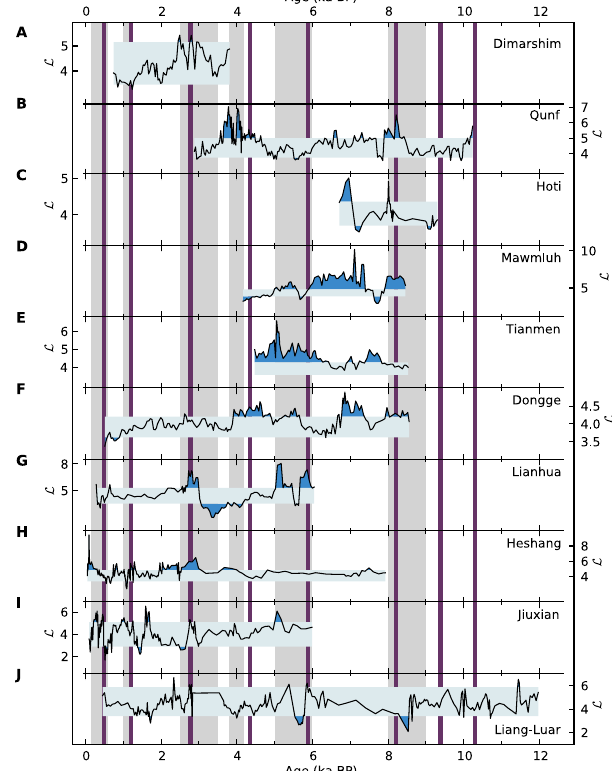
Figure 7. Time evolution of an indicator of rapid qualitative dy- namical change (RN average path length L ) in monsoon strength fluctuations obtained from a sliding window analysis of the residual oxygen isotope records displayed in Fig. 4 (using the original pub- lished age models without taking dating uncertainties into account). The predominant dynamical regime or baseline state is marked by 90% confidence bounds from a stationarity test (horizontal light blue bands). Deviations from this baseline indicate epochs (regime shifts) of significant climatic change (filled-in dark blue areas). Bond events (violet lines) and RCC episodes (grey bands) are dis- played for